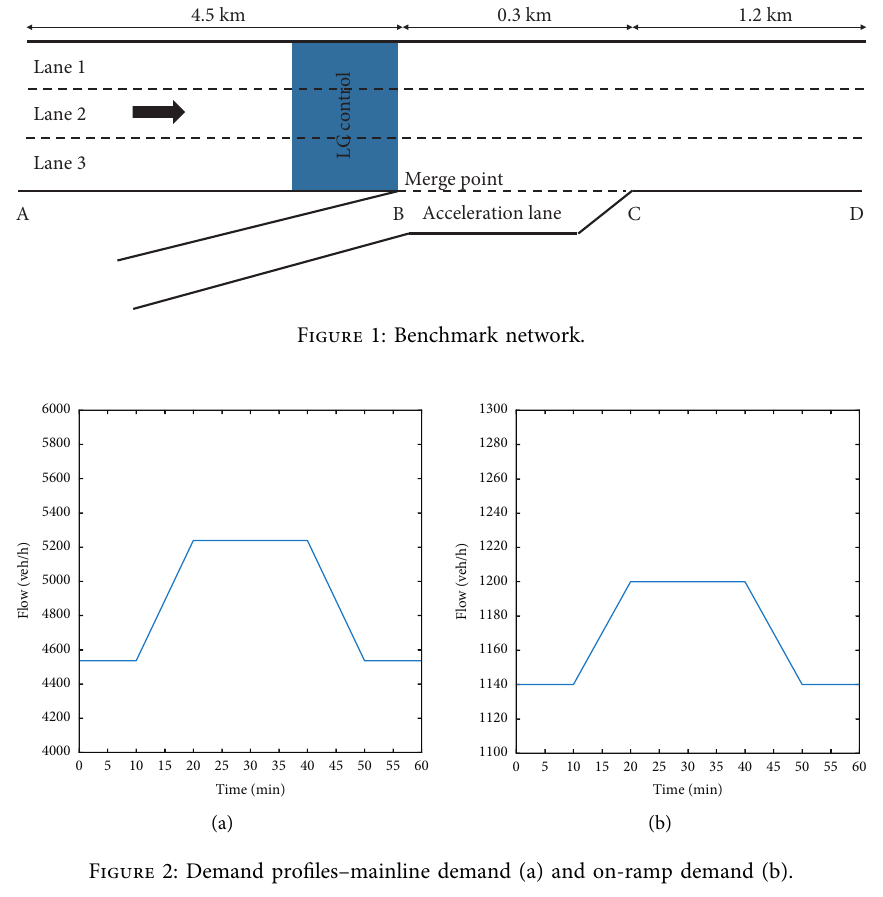
Figure 2: Demand profiles–mainline demand (a) and on-ramp demand (b).